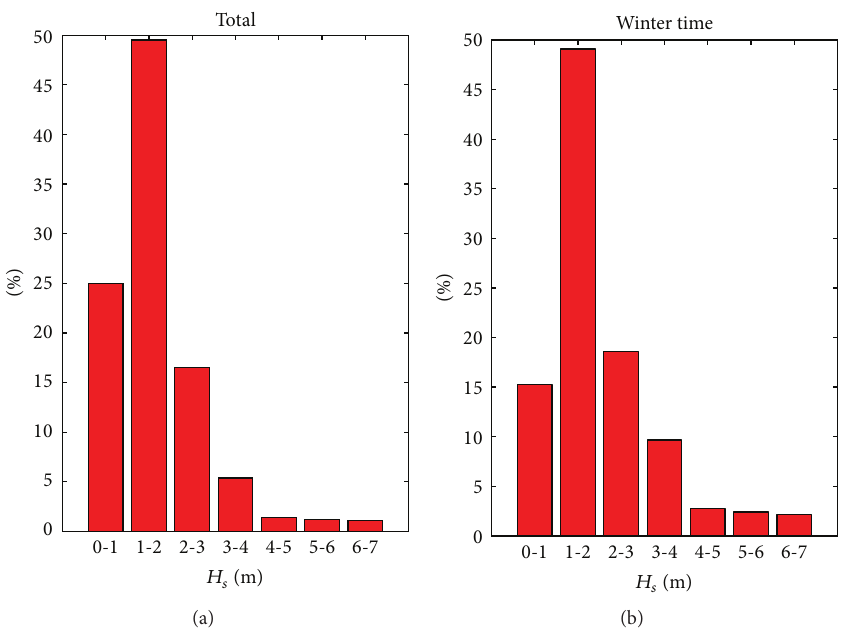
Figure 2: Analysis of the wave data measured at buoy close to the target area in the period 2006–2011: (a) Classes of significant wave height ( 𝐻 𝑠 ) for the total time interval; (b) 𝐻 𝑠 classes for